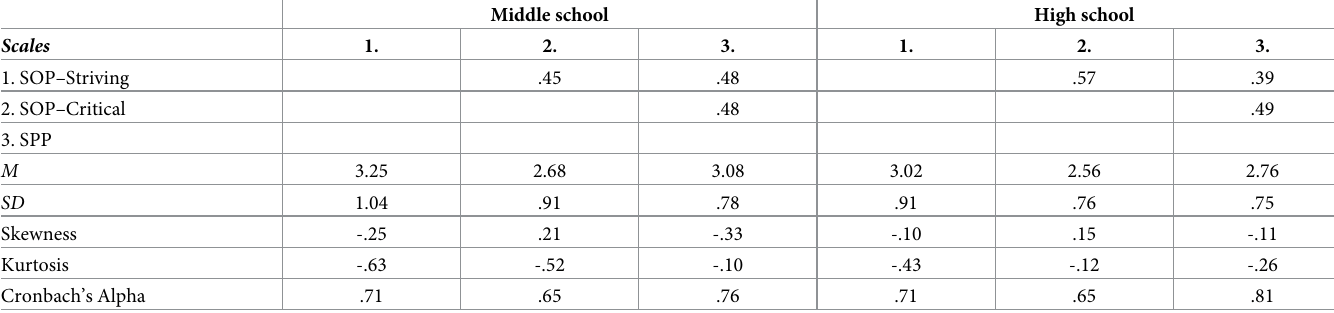
Table 1. Descriptive statistics and scale intercorrelations for the